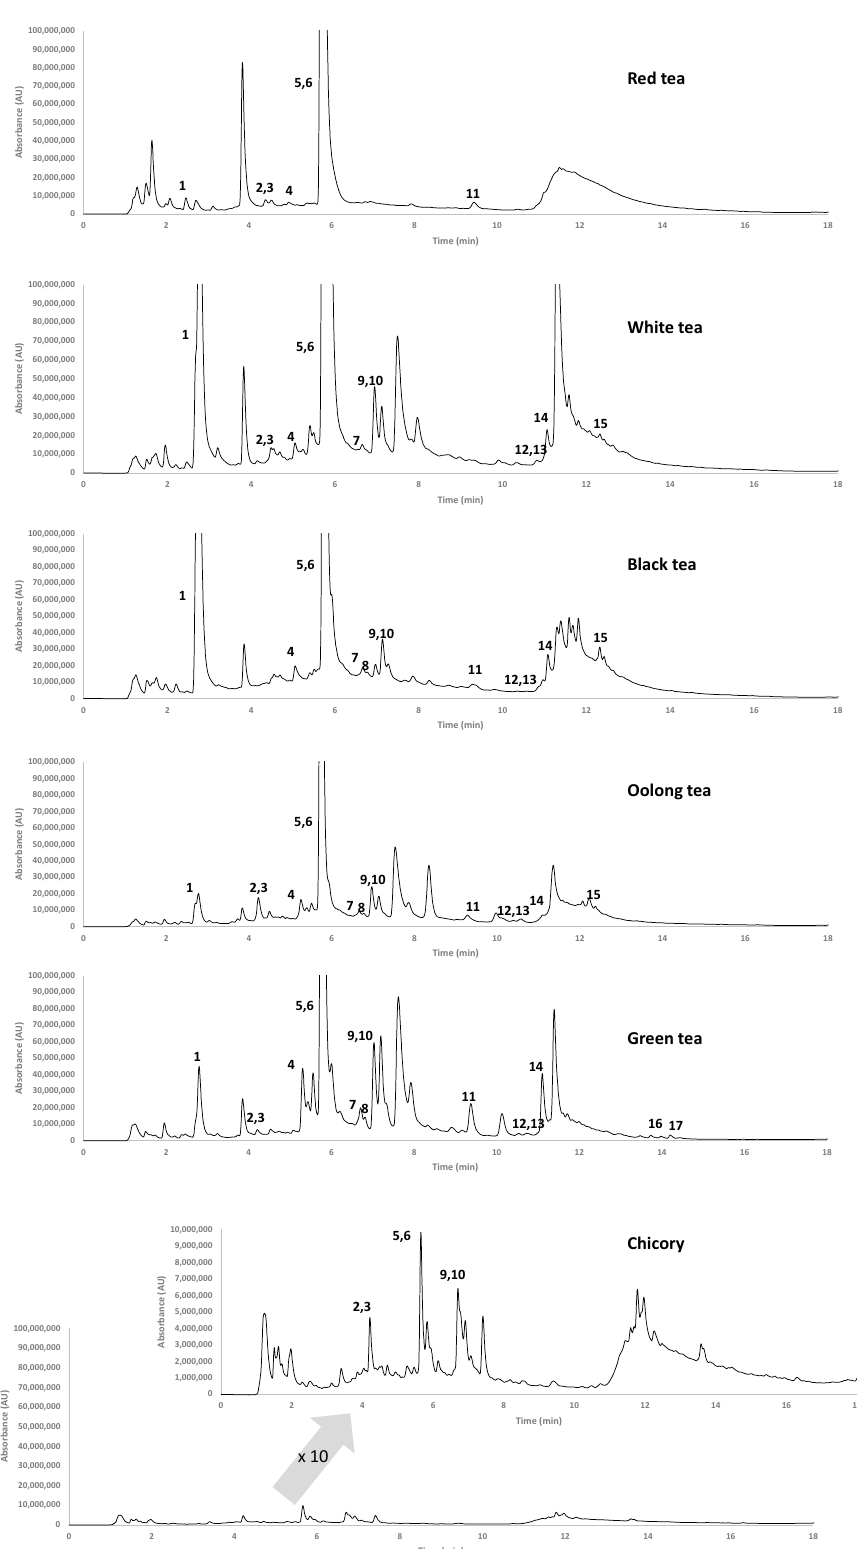
Figure 1. HPLC-UV chromatograms recorded at 280 nm for selected samples for each tea variety and a chicory extract. Peak identification: 1, gallic acid; 2, protocatechuic acid; 3, quercetin; 4, ( − )-epigallocatechin; 5, (+)-catechin; 6, 4-hydroxybenzoic acid; 7, vanillic acid; 8, caffeic acid; 9, syringic acid; 10, ( − )-epicatechin; 11, p -coumaric acid; 12, ferulic acid; 13, sinapic acid; 14, rutin; 15, myrcetin; 16, apigenin; 17, kaempferol.